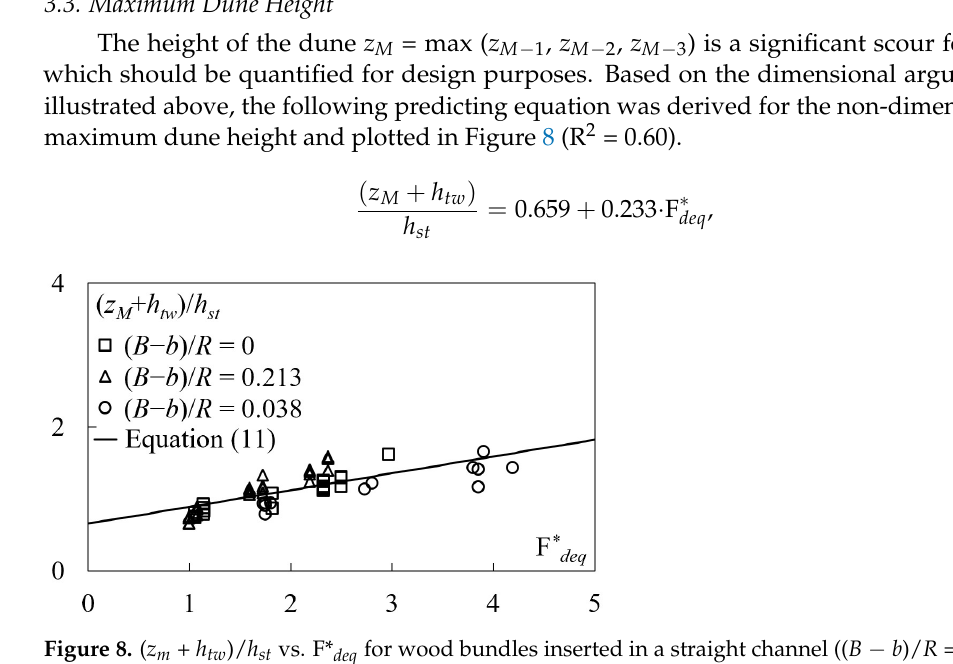
Figure 7. ( z mb + h tw )/ h st vs. F* deq for wood bundles inserted in the inner (( B − b )/ R = 0.213) bank of curved channel for different values of α , along with the plot of Equation (10).